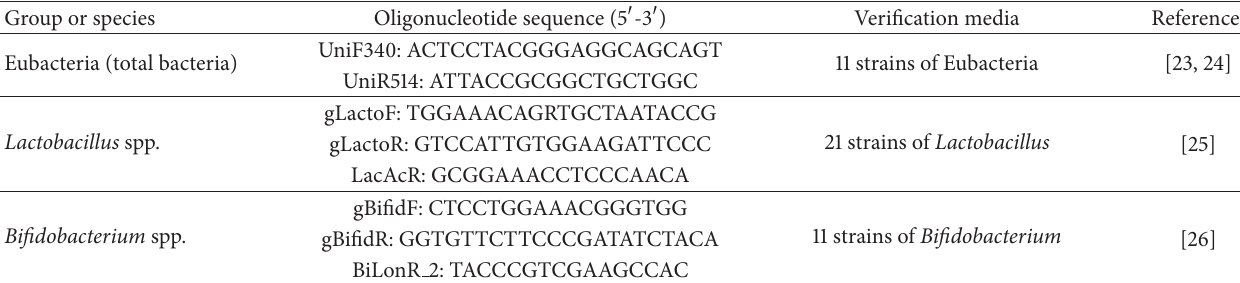
Table 1: Primers of groups in real-time polymerase chain